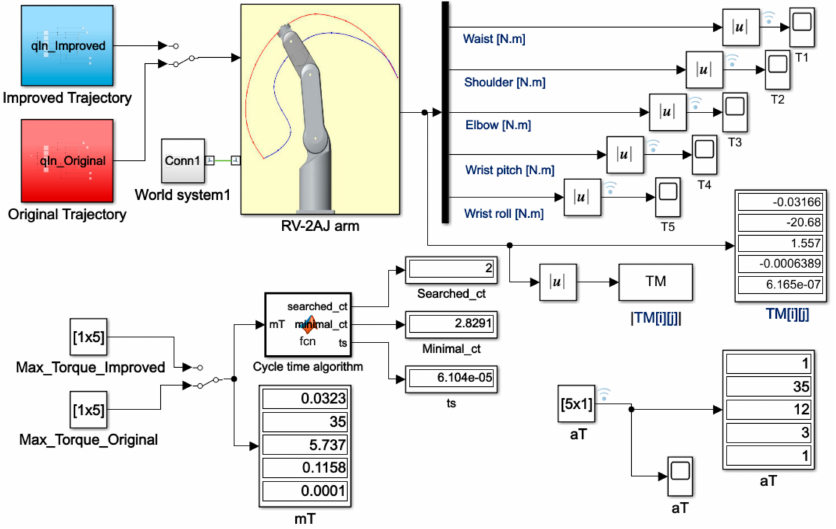
Figure 14. The block system scheme of RV-2AJ arm of the original trajectory.